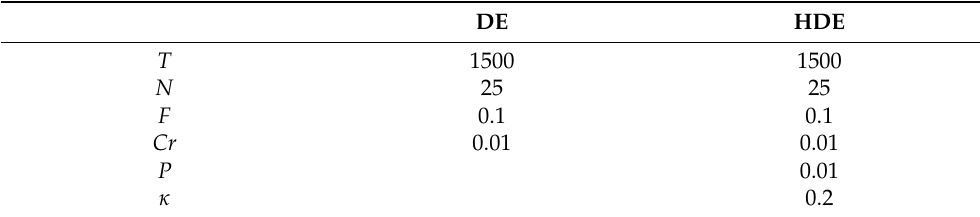
Table 1. Parameter settings of HDE and